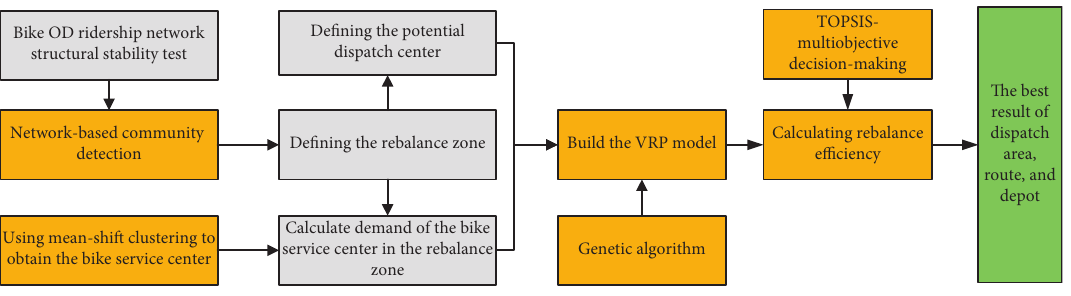
Figure 1: The workflow of this